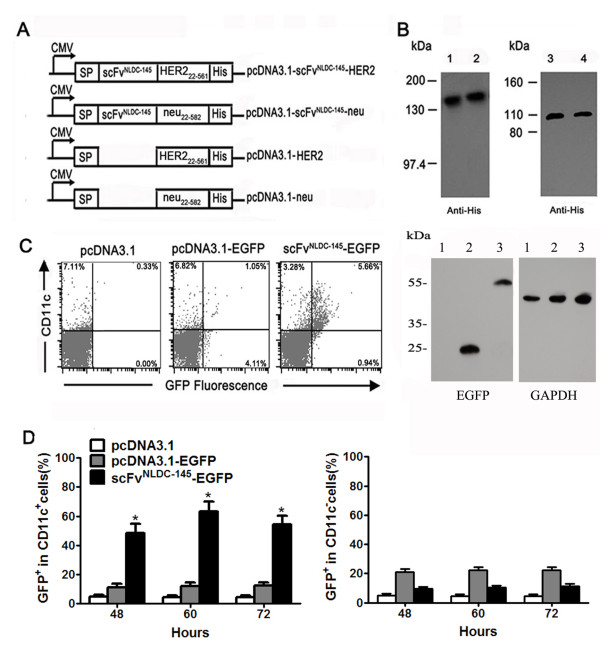
scFvNLDC-145 targets tumor antigen into DCs in vivo. A schematic representation of expression vectors. scFvNLDC-145-HER2, scFvNLDC-145-neu, pcDNA3.1-HER2, or pcDNA3.1-neu encode under the control of a CMV promoter, all the fusion proteins consisting of an signal peptide, amino acid residues 22 to 561 of human HER2 or amino acid residues 22 to 582 of rat neu, and COOH-terminal His tag. The control plasmids pcDNA3.1-HER2 and pcDNA3.1-neu lack the NLDC-145 domains. B 293T cells grown in 100-mm dishes were transfected with various expression vectors using Lipofectamine 2000 (invitrogen). Immunoblot analysis of supernatants from 293T cells transfected with scFvNLDC-145-HER2, scFvNLDC-145-neu, pcDNA3.1-HER2 and pcDNA3.1-neu (lane 1, 2, 3 and 4). Vaccine proteins were probed with mouse anti-His tag mAb followed by HRP-conjugated secondary anti-mouse antibody. C left, scFvNLDC-145-EGFP plasmid and controls as indicated were injected i.m. into mice, spleens were removed 48, 60, and 72 h thereafter, and stained with PE-conjugated anti-CD11c antibody. The GFP fluorescence in splenocytes was measured by flow cytometry. Representative results from one animal of each group 60 h post-injection. right, the expression of EGFP (MW,~25 kDa) and scFvNLDC-145-EGFP (MW,~55 kDa) fusion protein in injected muscle tissues detected by western blotting using anti- EGFP antibody 24 h after plasmid injection with GAPDH (MW,42 kDa) as loading control. Lane 1, mice treated with pcDNA3.1 control vaccine; lane 2, mice treated with EGFP-encoding vaccine; lane 3, mice treated with scFvNLDC-145-EGFP vaccine; D percentages of GFP+ DC in total DC (left panel); Percentages of GFP+ in CD11c-negative splenocytes (right panel). Bars, SE. *, P < 0.01, scFvNLDC-145-EGFP compared with other groups.